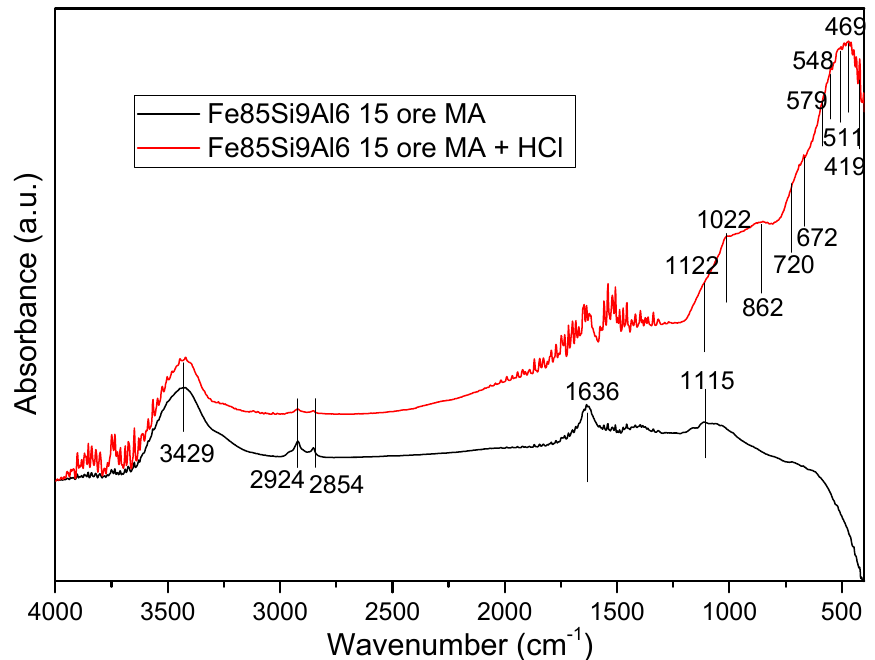
Figure 4. FTIR spectra of as-milled Fe-Si-Al alloy, before and after immersion in HCl solution.